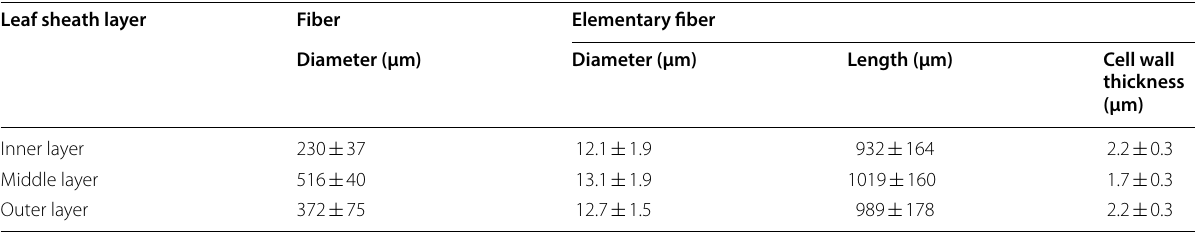
Table 1 Fiber and elementary fiber sizes in different palm leaf sheath layers Leaf sheath